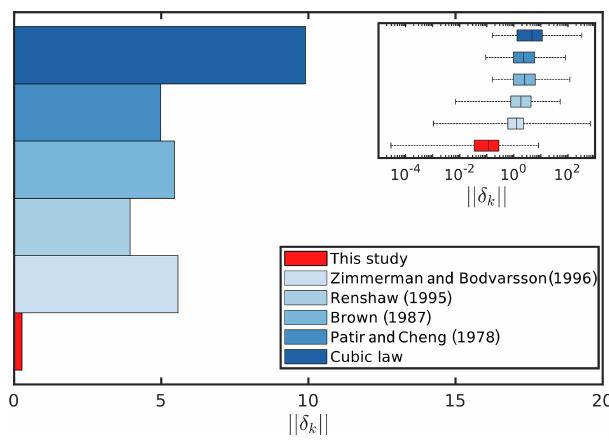
Figure 9. Mean error norm δ k (see Eq. 18) of all fractures con- sidered in this study for different prediction models. The mean er- ror norm recorded for this study is 0 . 267. Inlet plot shows box and whisker plots incorporating all outliers, i.e., representing minimum and maximum recorded